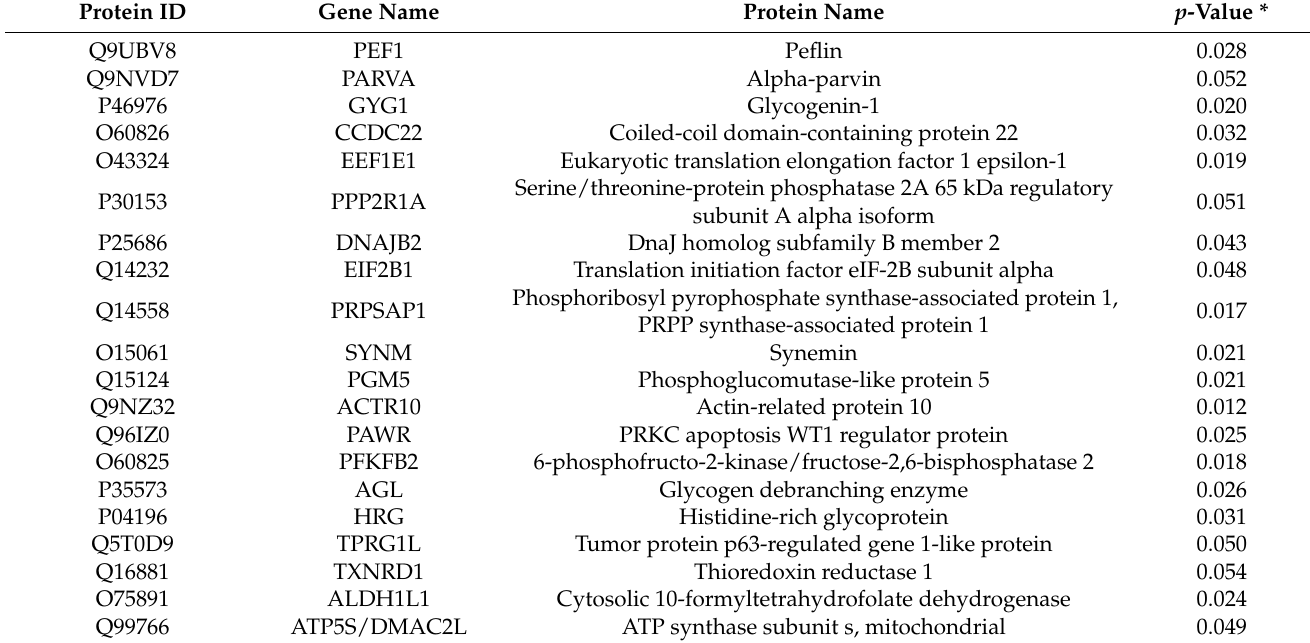
Table 2. Top 20 proteins with positive association to aortic regurgitation.